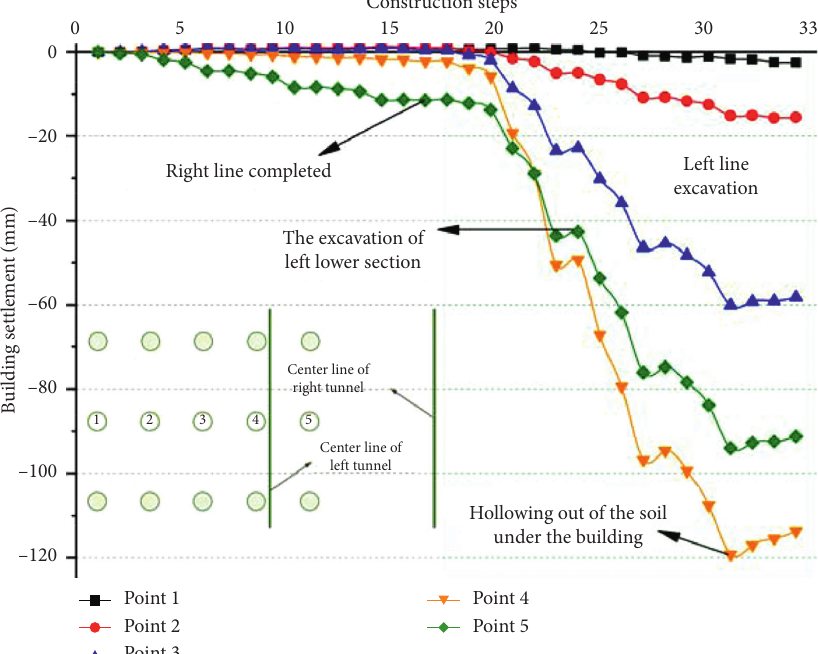
Figure 24: Building subsidence curves